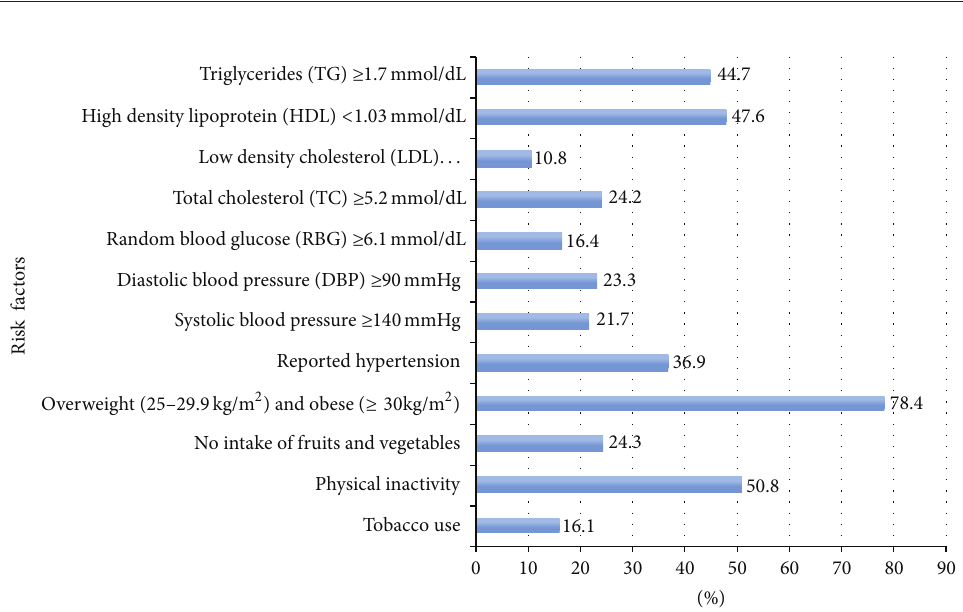
Figure 1: The prevalence of cardiovascular disease risk factors among the participants